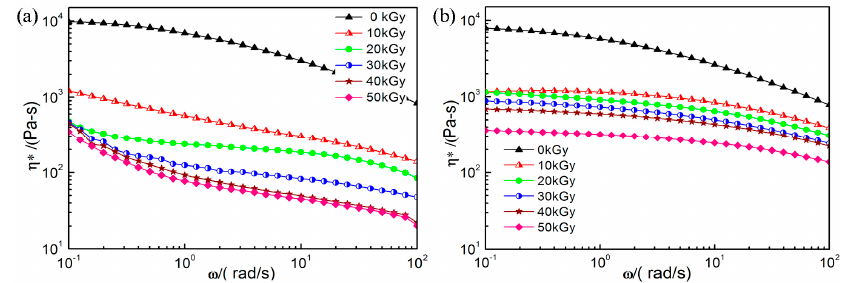
Figure 3. Amplitude oscillatory shear rheological properties at different doses: ( a ) pristine PP and ( b ) PP/TAIC (2 wt %).